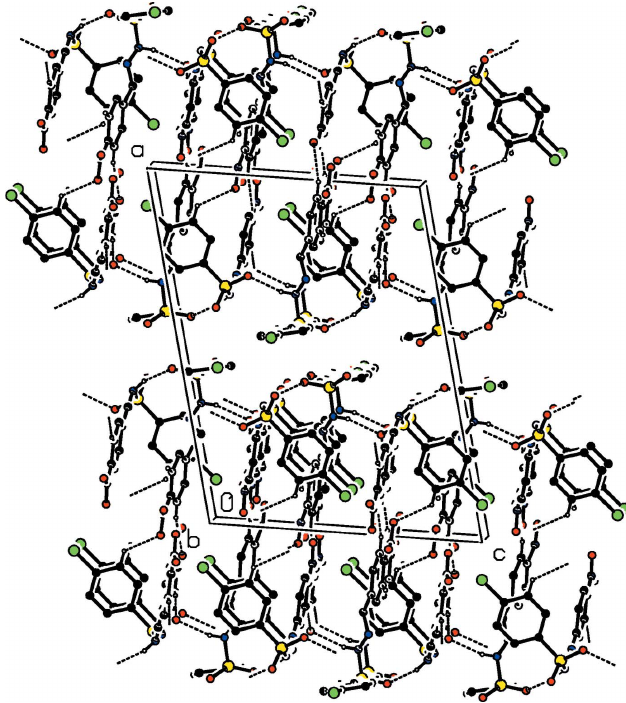
(Table 2) shown as dashed lines and C—Cl (cid:4)(cid:4)(cid:4) (cid:2) interactions as blue arrows. C-bound H atoms have been omitted.